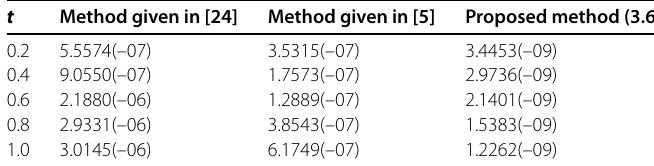
Table 4 Example 1: Case 1.2(a): Maximum absolute errors at δ = 1